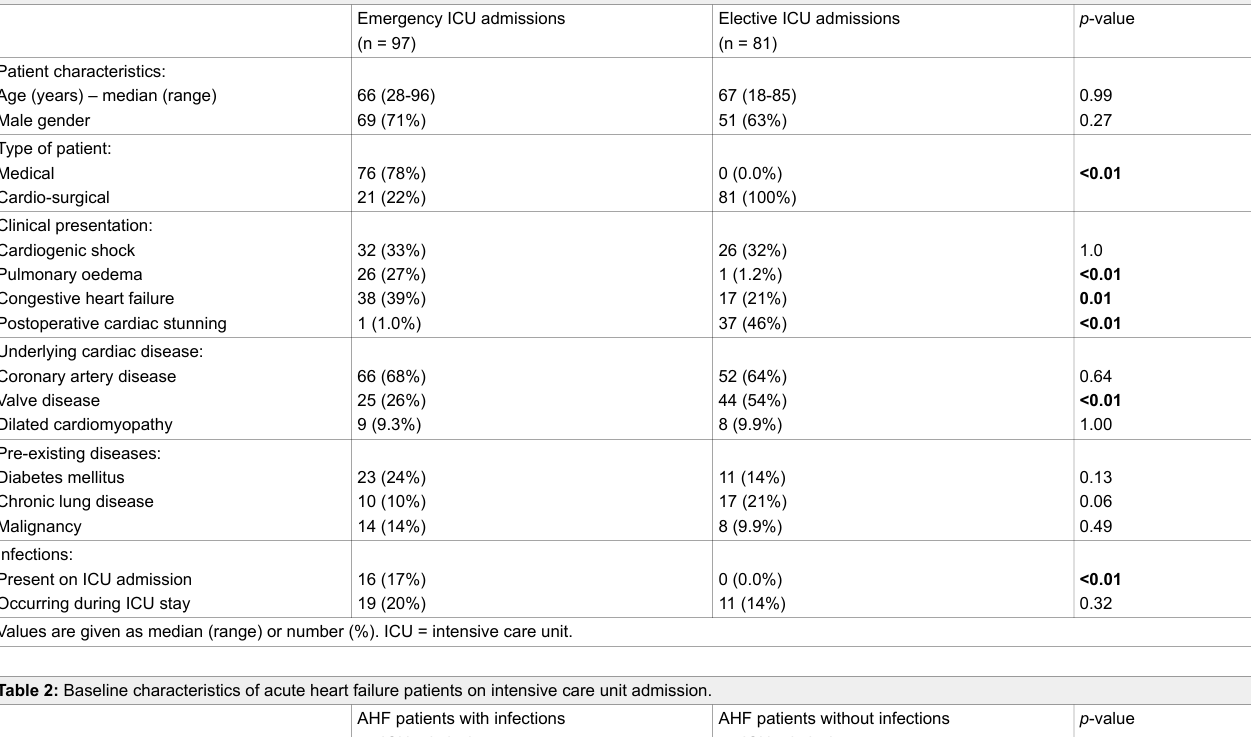
Table 1: Baseline characteristics of acute heart failure patients on intensive care unit admission.